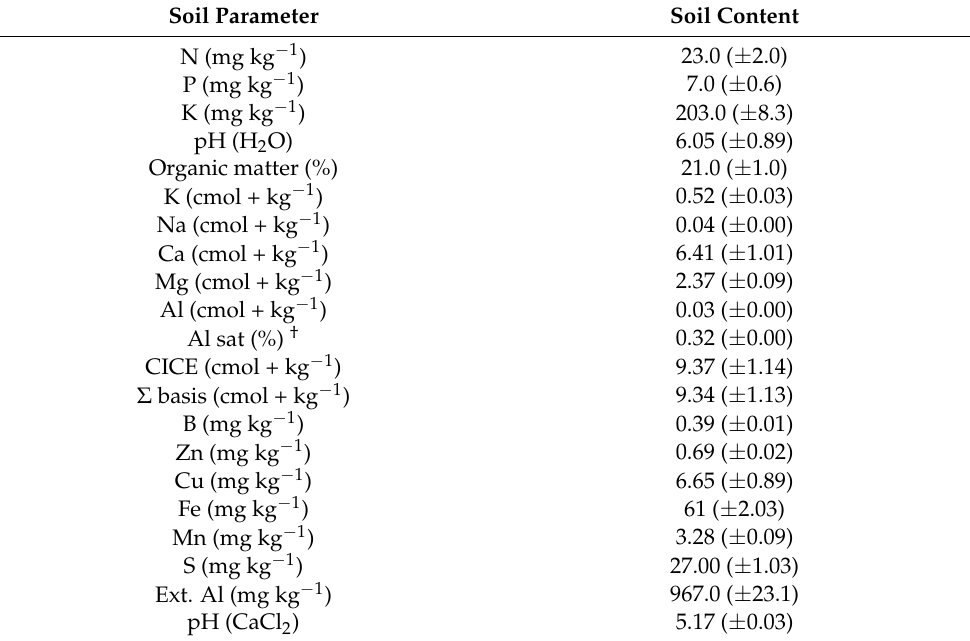
Table 2. Average values ( ± standard error) of chemical properties of Andisol (Freire series), where experiment was performed in hazelnut orchard. † Calculated as Al/cation exchange capacity [ Σ (K, Ca, Mg, Na, and Al)] × 100, n = 3. Soil